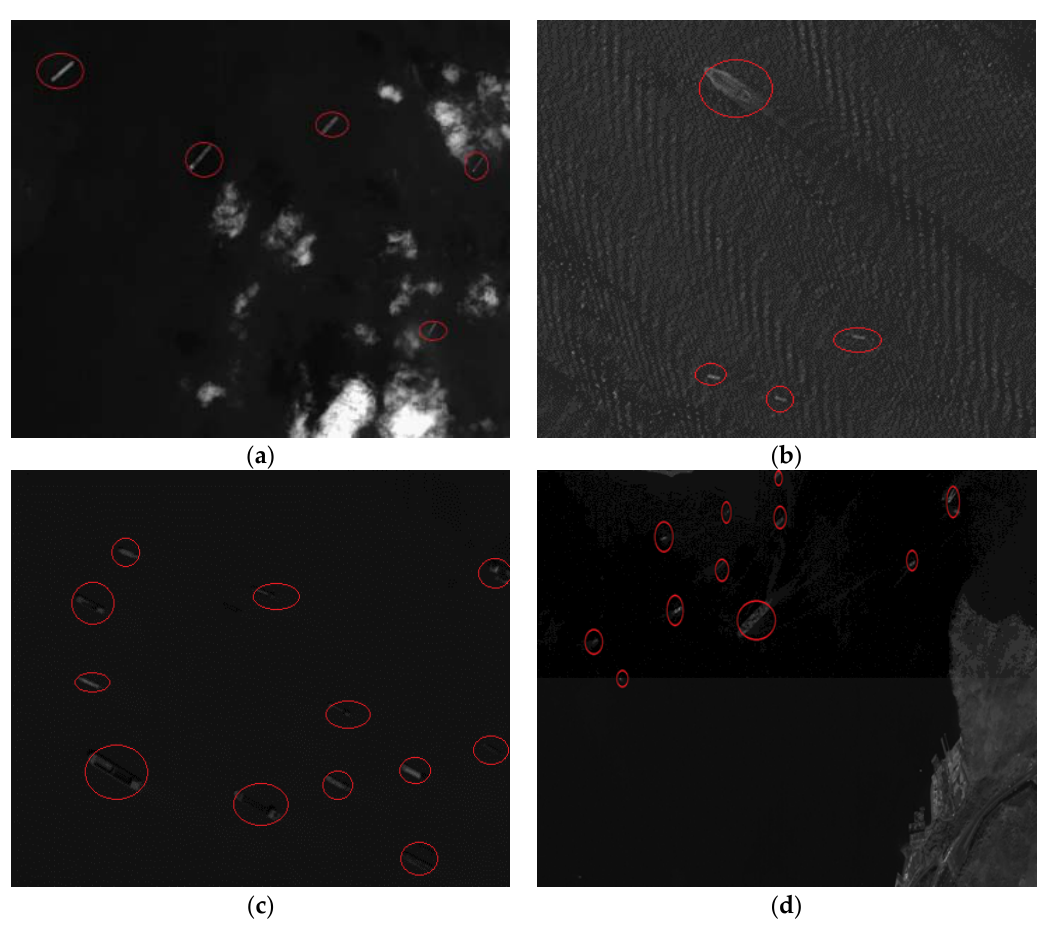
Figure 18. The detected ships. ( a ) Cloud coverage; ( b ) visible swell; ( c ) low contrast; and ( d ) simple sea.